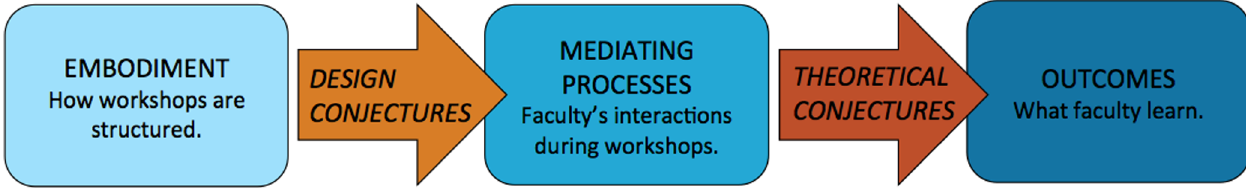
FIG. 1. A visual representation of conjecture mapping for workshop design. Adapted from Sandoval [27], Fig.